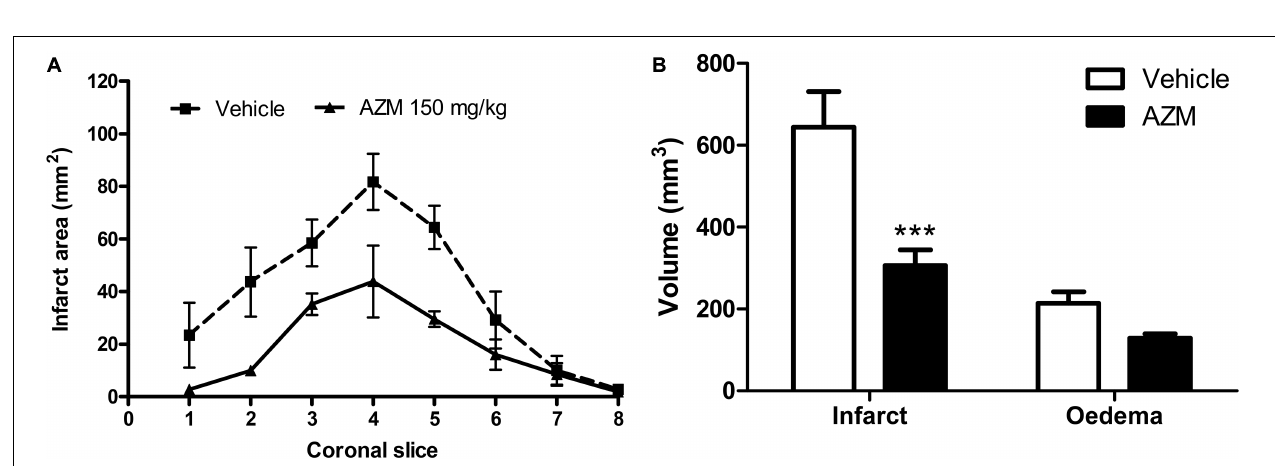
FIGURE 7 | A single dose of azithromycin administered 4.5 h after MCAo reduces ischemic brain damage measured 24 h after the insult. (A) Infarct area and (B) volumes of infarct and edema of rats subjected to 4.5 h of MCAo followed by 19.5 h of reperfusion. Rats were injected i.p. with vehicle (0.9% NaCl) or azithromycin (AZM, 150 mg/kg) upon reperfusion. Data are expressed as mean ± SEM of four independent experiments ( n = 4 rats per experimental group); ∗∗∗ P < 0.001 vs. vehicle (two-way ANOVA followed by Bonferroni post hoc test).